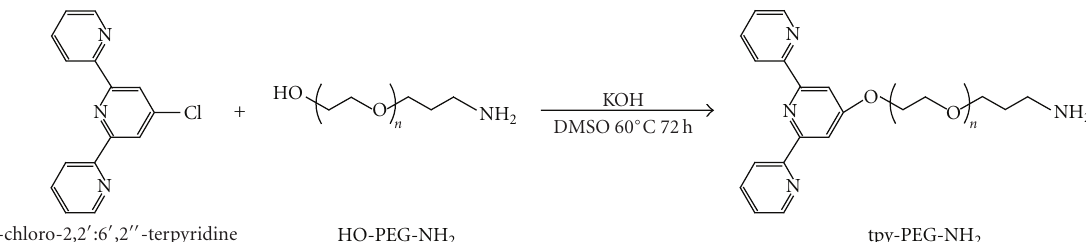
Scheme 1: Synthesis procedure of macroinitiator, tpy-PEG-NH 2 .